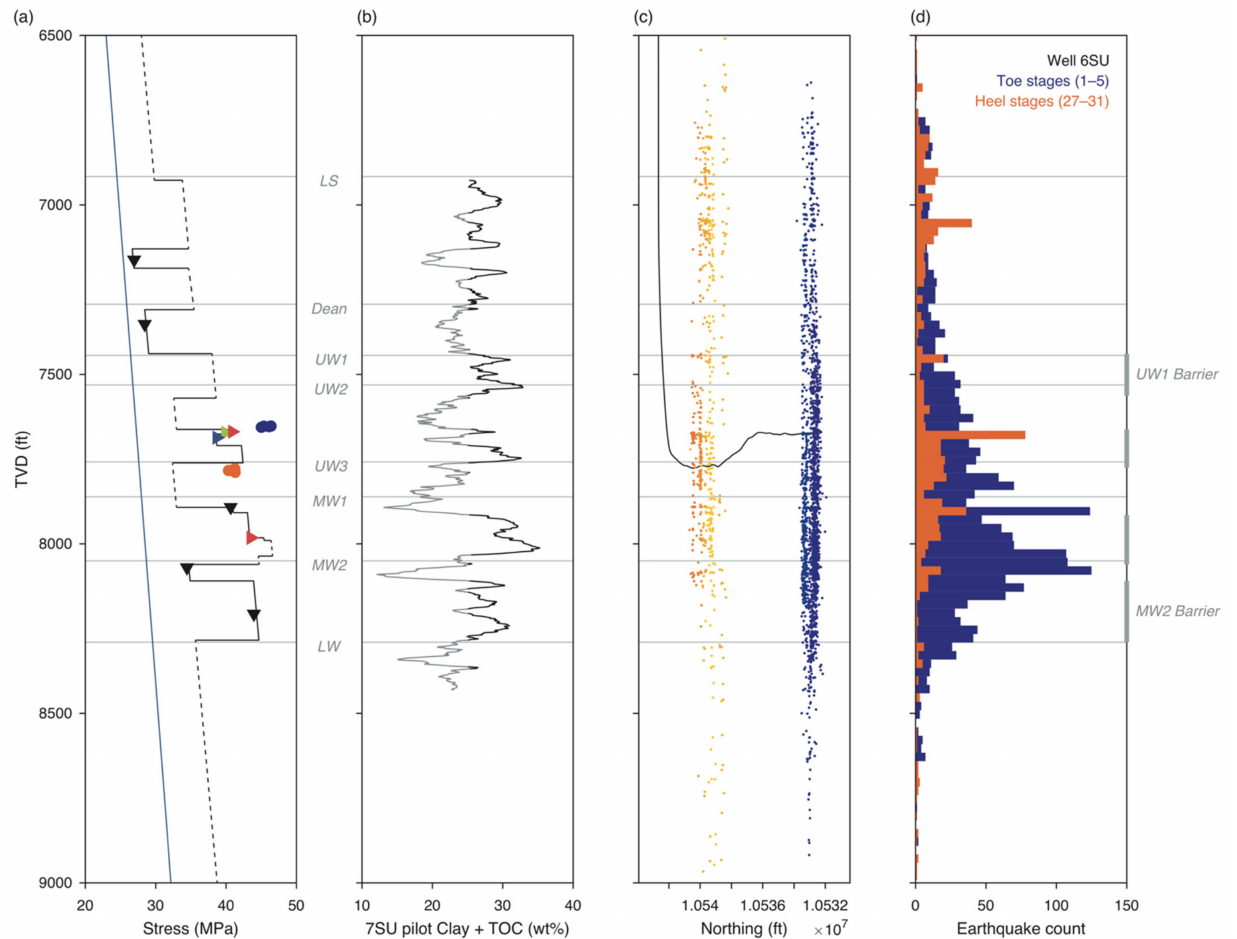
Figure 5. Relationship between stress, composition, and seismicity in well 6SU. ( a ) Interpreted stress profile including DFITs from vertical wells (black triangles), DFITs from horizontal wells (colored triangles), and instantaneous shut-in pressure (ISIP) for 6SU stages 1–5 (blue points) and 27–31 (red points). ISIP values are expected to be ~3–5 MPa higher than DFITs. ( b ) Clay + TOC in the 7SU pilot well. ( c ) Distribution of microseismic events colored by stage from the five toe stages (blue) and five heel stages (red to orange). ( d ) Histogram of microseismic event depths from the five toe stages (blue) and five heel stages (red to